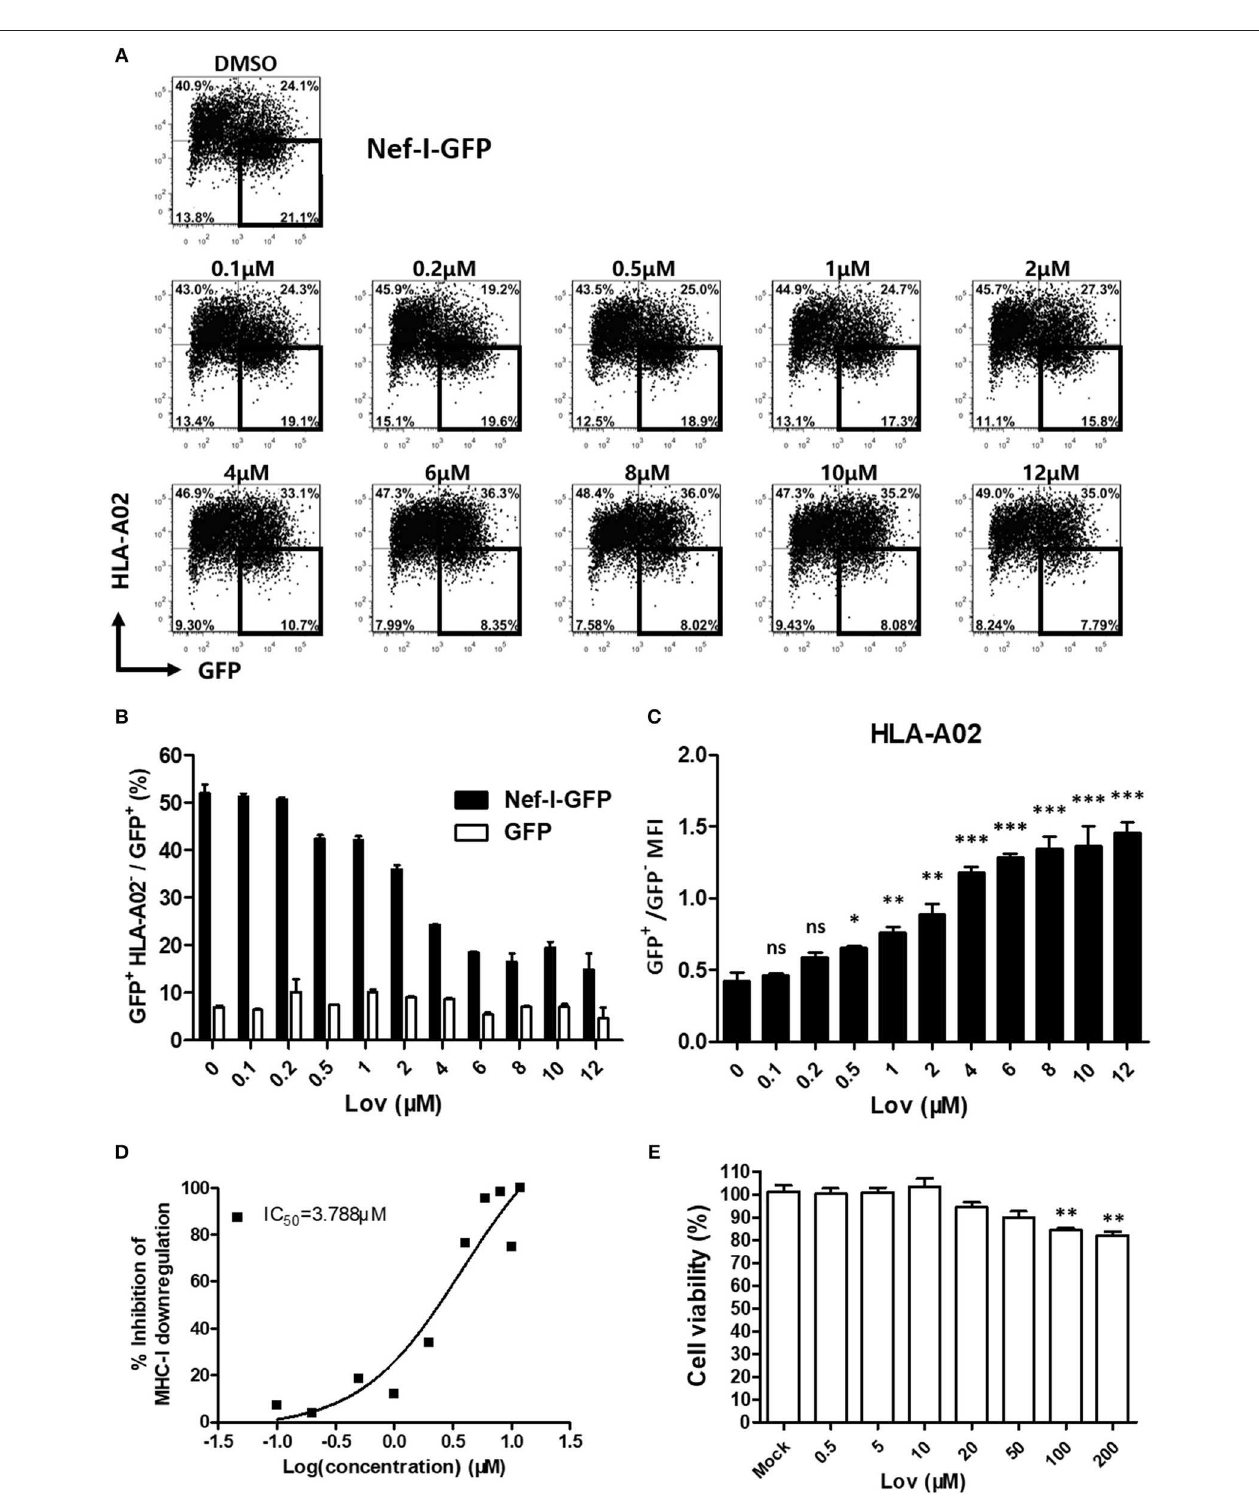
FIGURE 2 | Lovastatin potently represses the ability of Nef to downregulate MHC-I. Twelve hours after transfection of pcDNA3.1-Nef-IRES-GFP (800 ng per well), HEK293T cells were treated with lovastatin from 0.1 to 12 µ M. Forty-eight hours after transfection, FACS analysis was performed for the percentages of GFP + MHC-I − cells (A) . The ratios of GFP + MHC-I − to GFP + population from pcDNA3.1-Nef-IRES-GFP or pcDNA3.1-IRES-GFP transfections were summarized with bar